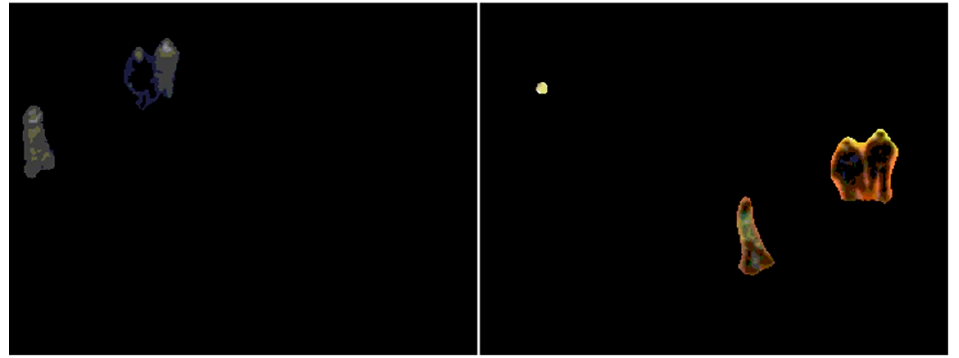
Figure 9. Foregrounds extracted from infrared ( the left ) and from visible ( the right ) images in Frame 366 of LITIV-8.